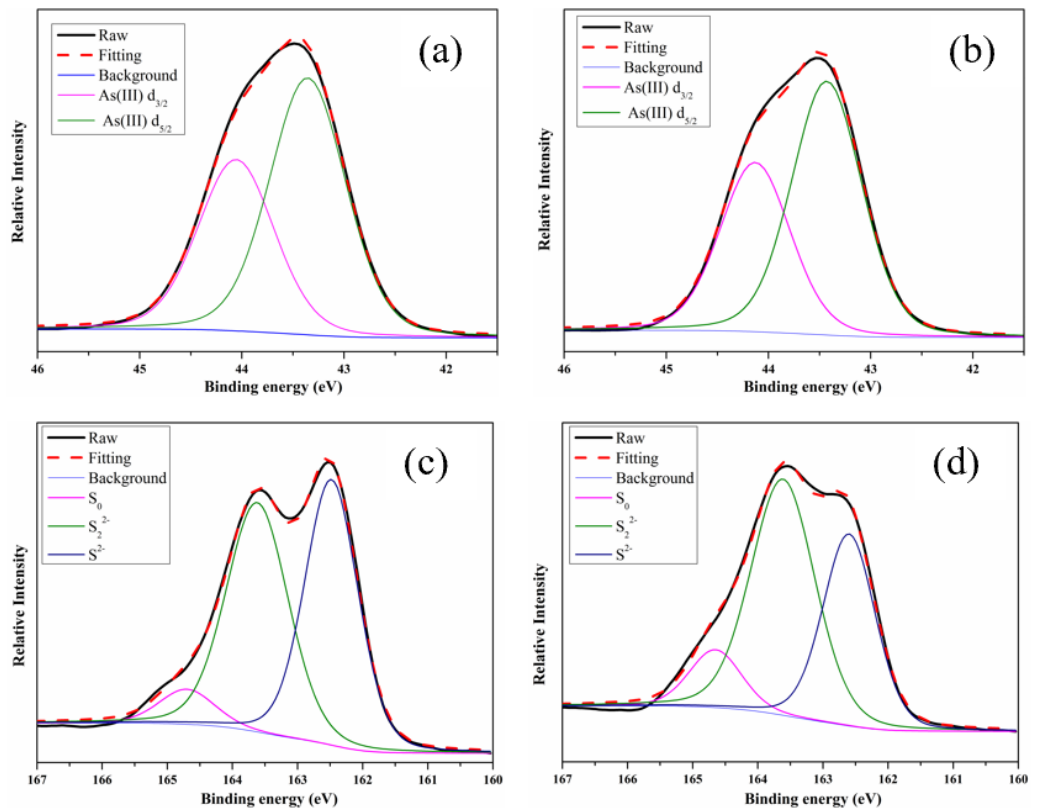
Figure 8. XPS spectra of ( a ) As 3d of precipitate-As(III); ( b ) As 3d of precipitate-As(V); ( c ) S 2p of precipitate-As(III); ( d ) S 2p of precipitate-As(V). Table 2. Bending energy, FWHM, and peak positions from the XPS spectra of As 3d and S 2p. Samples